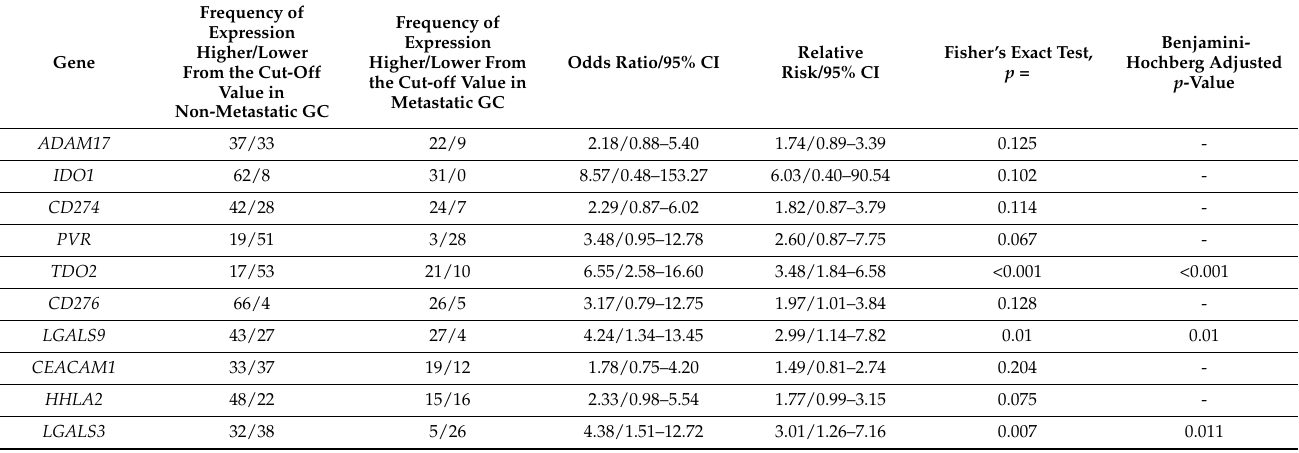
Table 3. The frequencies of gene expression level relative to the cut-off value in groups of patients with GC metastases and without metastases and the association of gene expression with metastasis by Fisher’s exact test.